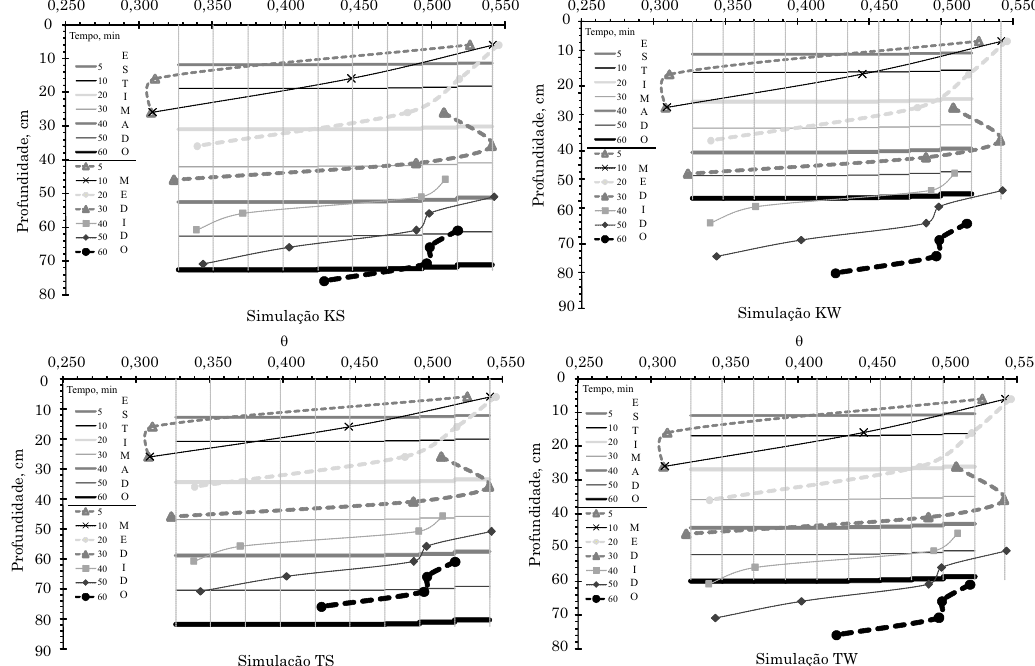
Figura 5. Perfis de umidade medidos e estimados com o GAML-c no 1º teste experimental.